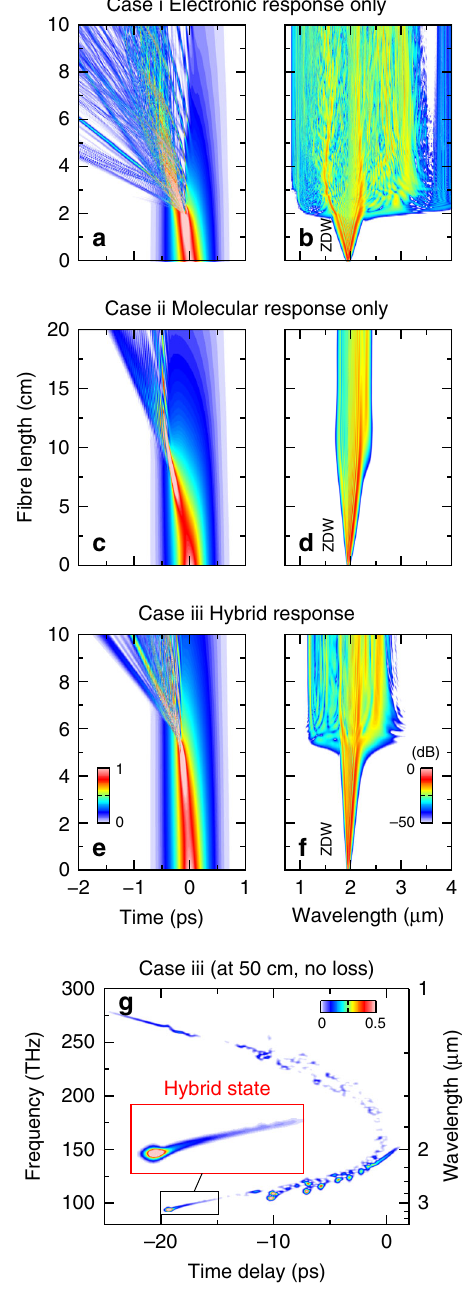
Fig. 2 Impact of hybrid soliton dynamics on supercontinuum generation. Comparison of a , c , e temporal and b , d , f spectral evolutions of a high- power pulse (10 kW peak power, τ FWHM = 450 fs, λ p = 1.95 m) in three nonlinear systems with the same loss, dispersion and nonlinear parameters, but different nonlinear responses: a , b entirely instantaneous response ( f m = 0), c , d entirely non-instantaneous response ( f m = 1) and e , f hybrid response of CS 2 ( f m = 0.85). The linear colour scale in the temporal domain a , c , e represents power normalised to the peak power of the initial pulse; the power scale in the spectral domain b , d , f is logarithmic ( − 50 to 0 dB). ZDW stands for zero-dispersion wavelength. g Spectrogram of the hybrid system assuming lossless propagation over 50 cm. The linear colour scale represents power normalised to 50% of the initial peak